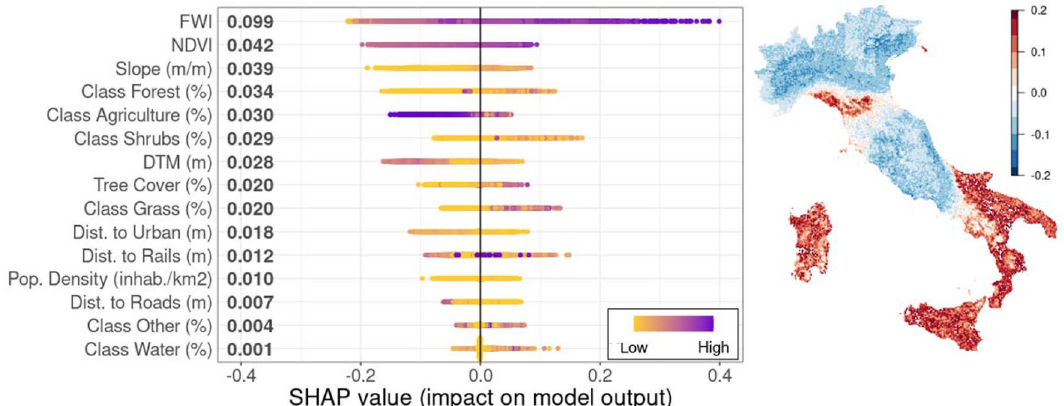
Figure 5. (Left panel) Shapley values for wildfire occurrence prediction. On the y-axis, the features are sorted by decreasing importance while the x-axis shows the SHAP value distribution and denotes whether a variable contributes to reduce or to increase the fire probability. Gradient colors indicate the original value for that variable. Each point represents a row from the original dataset. (Right panel) Fire Weather Index (FWI) Shapley values. For sake of readability, SHAP values exceeding the [− 0.2, 0.2] range were assigned the same colors of extreme points of the chosen interval. The map was produced by using the plot.raster function from "raster" R package.